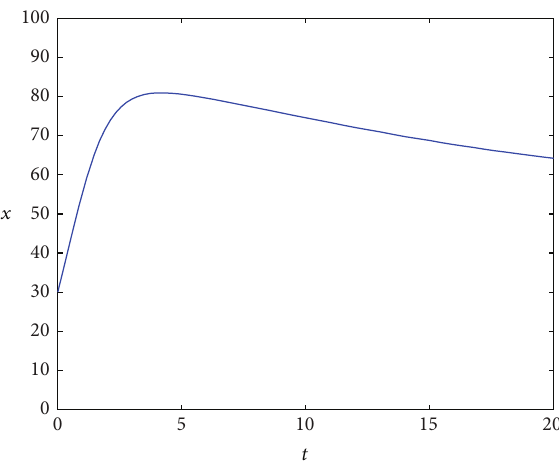
Figure 1: Plot of prey population 𝑥 in unreserved area versus 𝑡 .